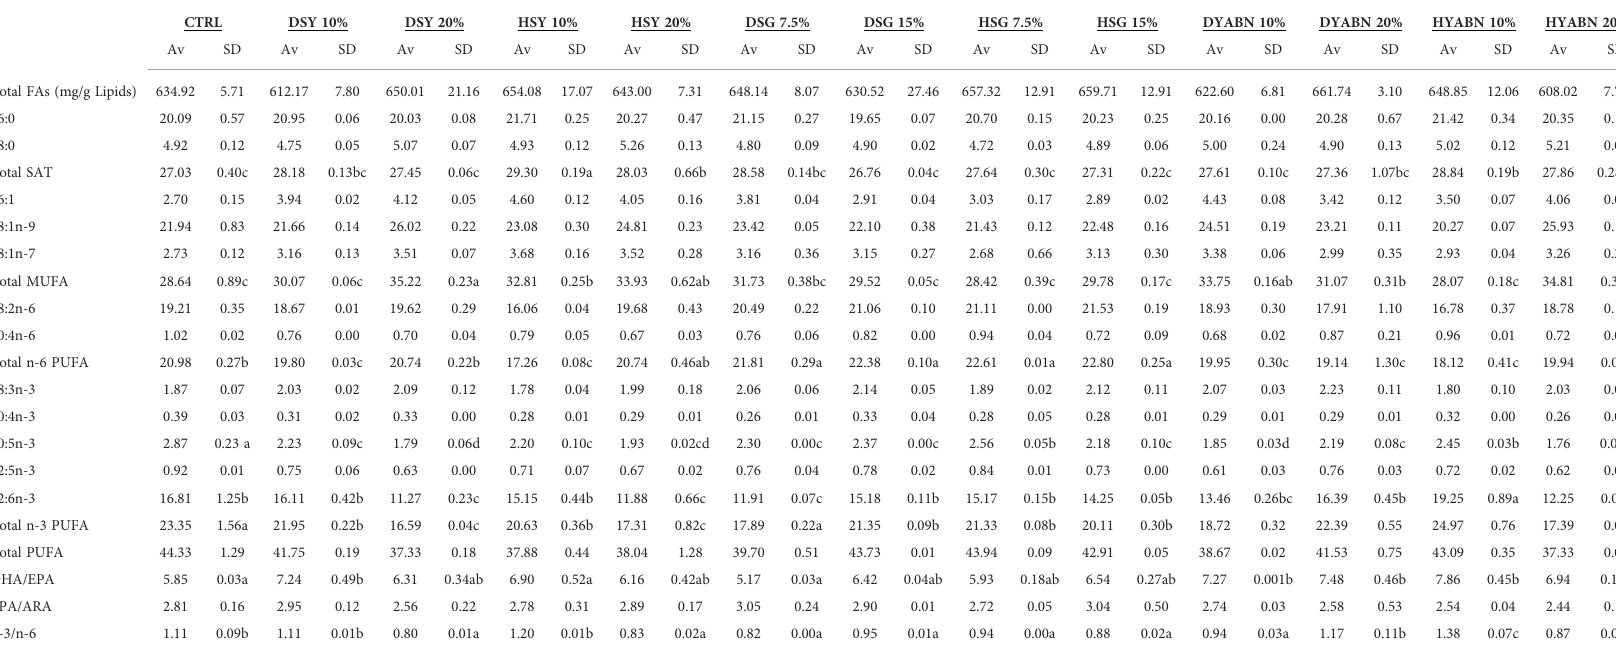
TABLE 7 Fatty acid composition (% of total FAs, only main fatty acids and totals are included) of the muscle of the fi sh collected at the end of the trial.